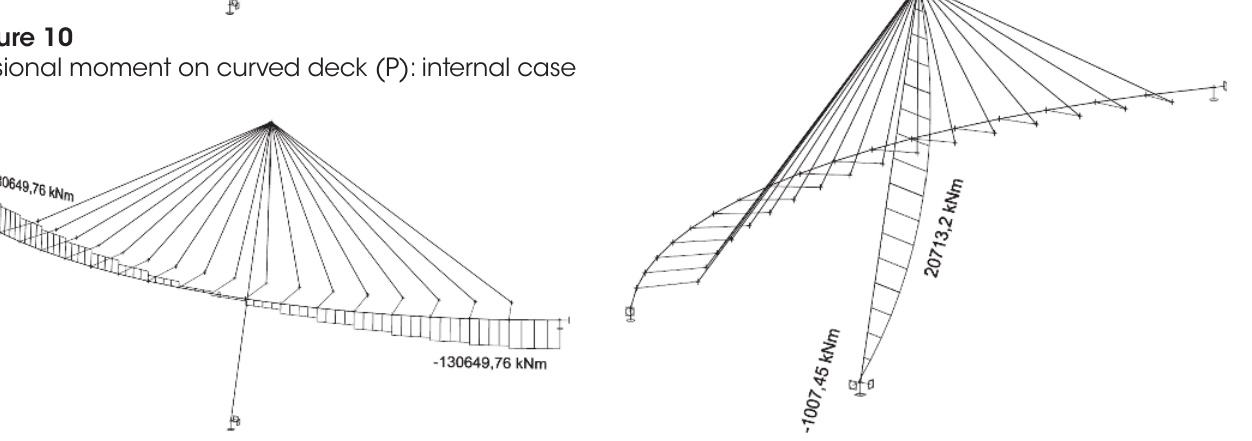
Figure 14 Bending moment on pylon (P+L): internal